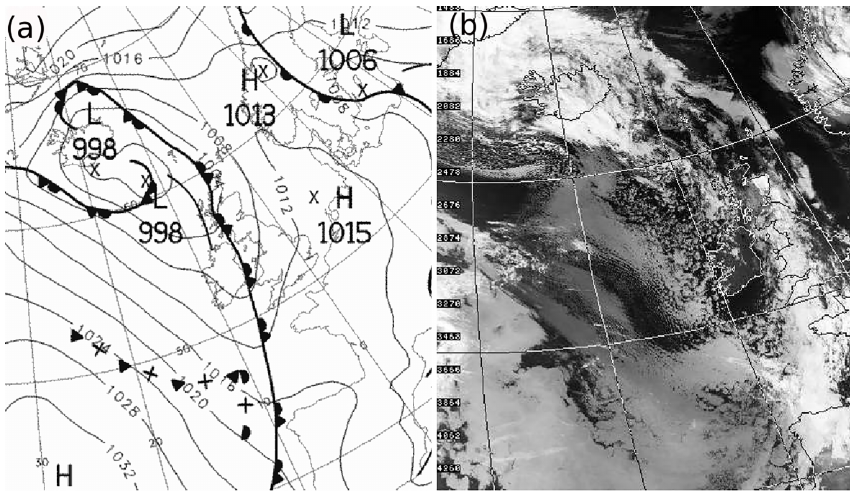
Figure 1. (a) UK Met Office surface analysis chart at 00:00UTC on 14 May 2010. Mean sea level pressure isobars overlaid with surface fronts. (b) AVHRR infrared satellite image at 06:13UTC on the 14 May 2010 provided by the Dundee satellite receiving